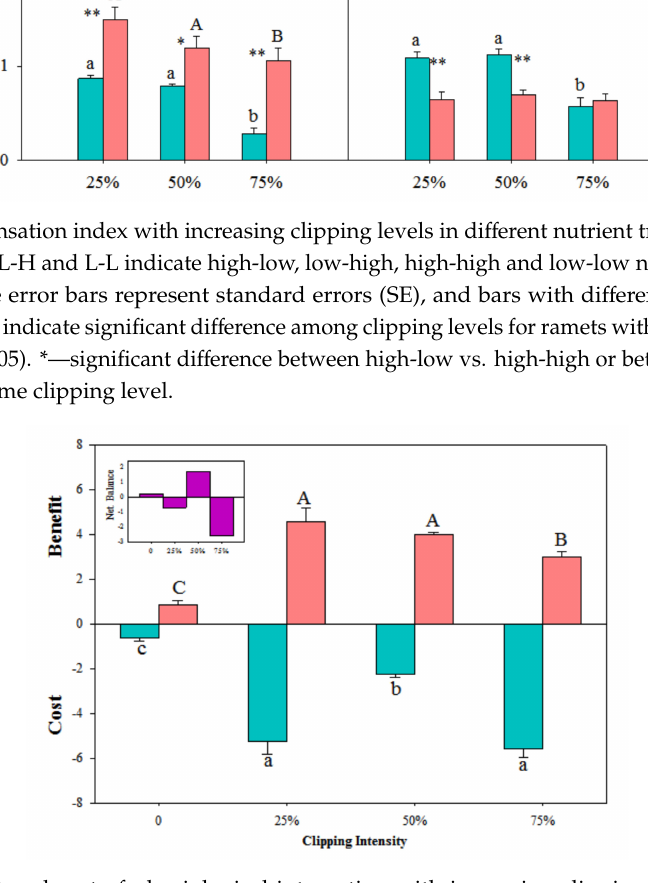
Figure 6. Benefit and cost of physiological integration with increasing clipping levels. The error bars represent standard errors (SE), and bars with di ff erent lower-case and upper-case letters indicate significant di ff erence in cost and benefit, respectively, at di ff erent clipping levels ( p <